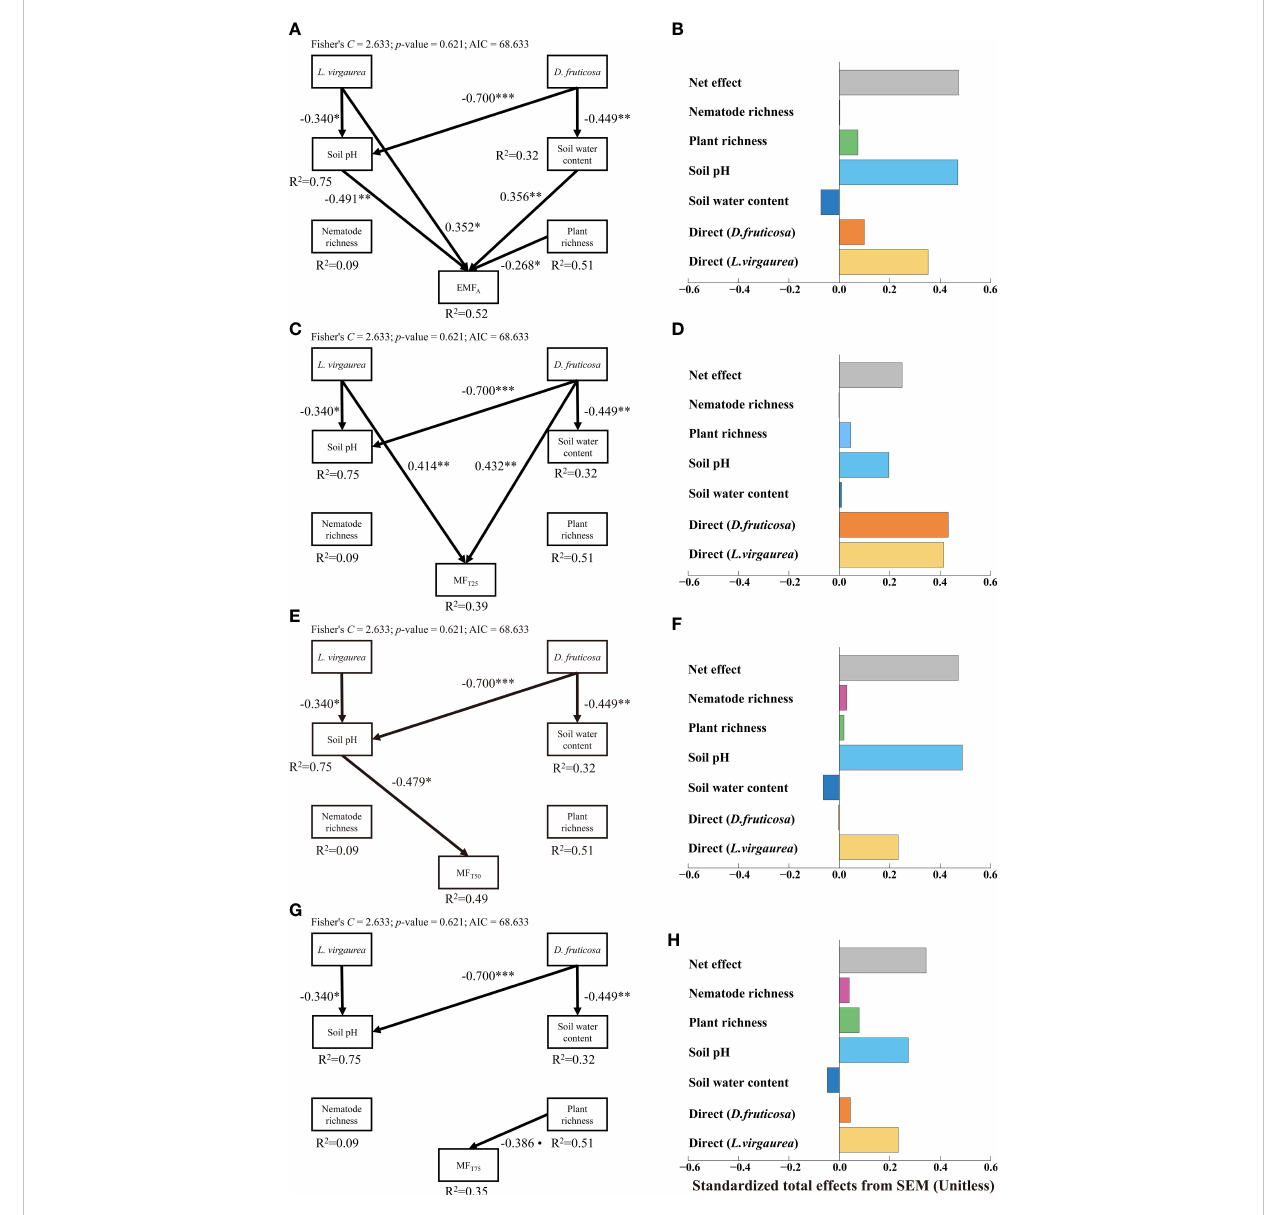
FIGURE 3 Structural equation model assessing the direct and indirect effects of dominant plants on EMF A (A) , MF T25 (C) , MF T50 (E) and MF T75 (G) . Numbers adjacent to arrows are indicative of the effect size of the relationship. Only signi fi cant and marginally signi fi cant pathways were shown. Signi fi cance levels are as follows: (cid:129) , p < 0.10; * p < 0.05; ** p < 0.01; *** p < 0.001. The right panel of the fi gure showed that total, direct and indirect standardized effects of the different drivers of EMFA (B) , MF T25 (D) , MF T50 (F) and MF T75 (H)